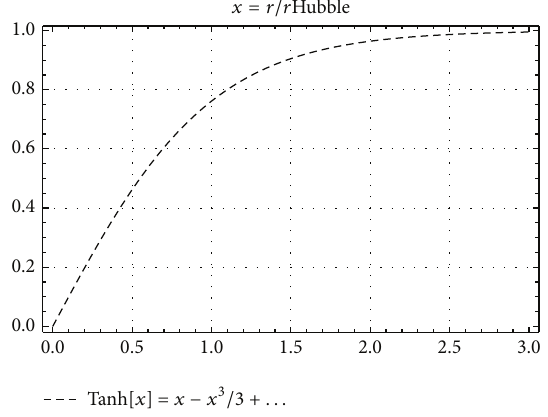
Figure 7: Relativistic Hubble expansion: tanh function.